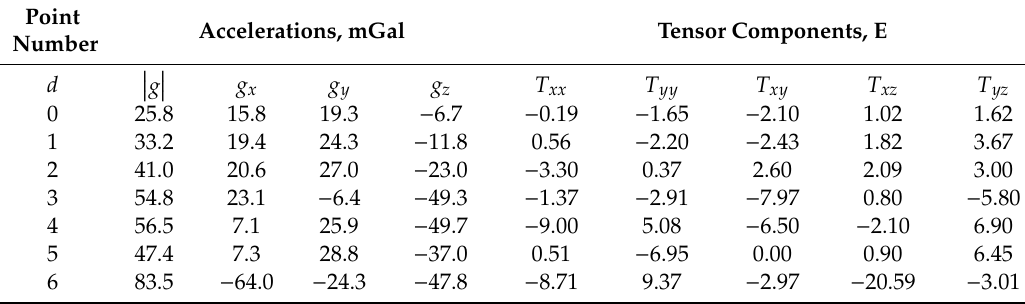
Table 4. Route points characteristics for the region with medium-amplitude anomalies. Point